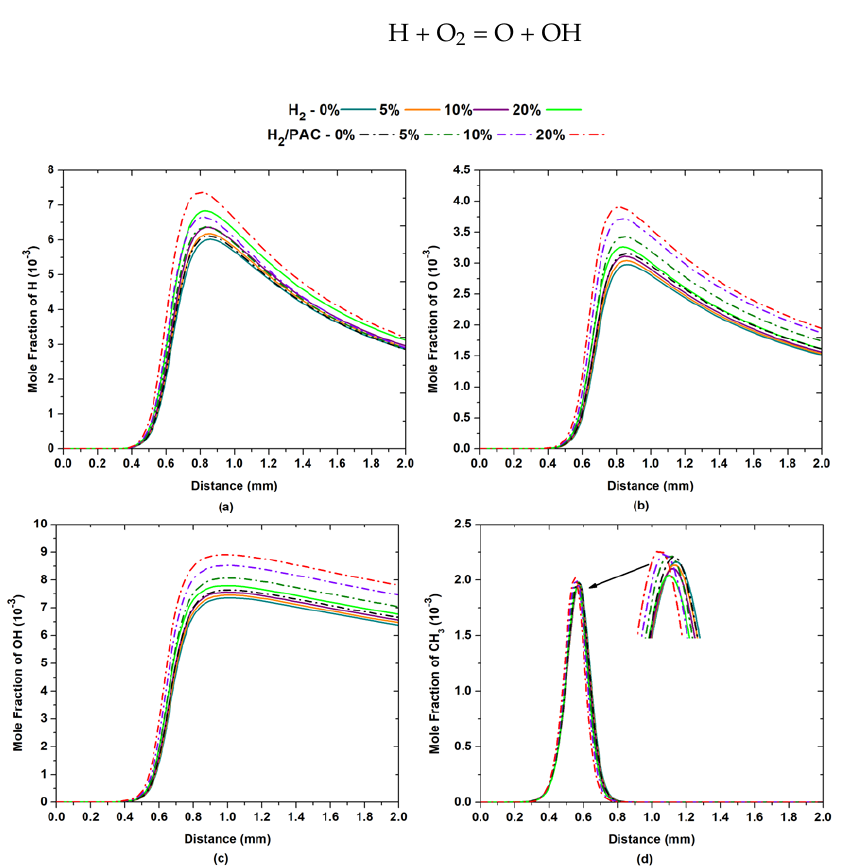
Figure 10. Mole fraction profiles of ( a ) H, ( b ) O, ( c ) OH, and ( d ) CH 3 with different blends of hydrogen without or with